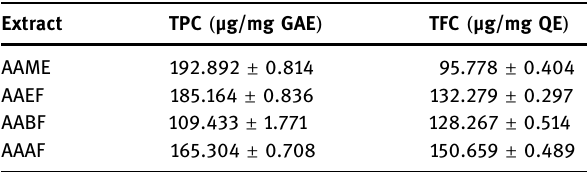
Table 4: Calculation of TPC and TFC of A. alpinum